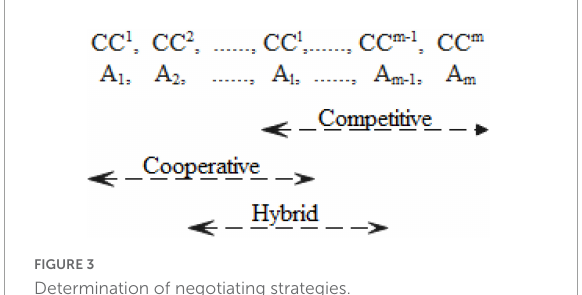
FIGURE3 Determination of negotiating